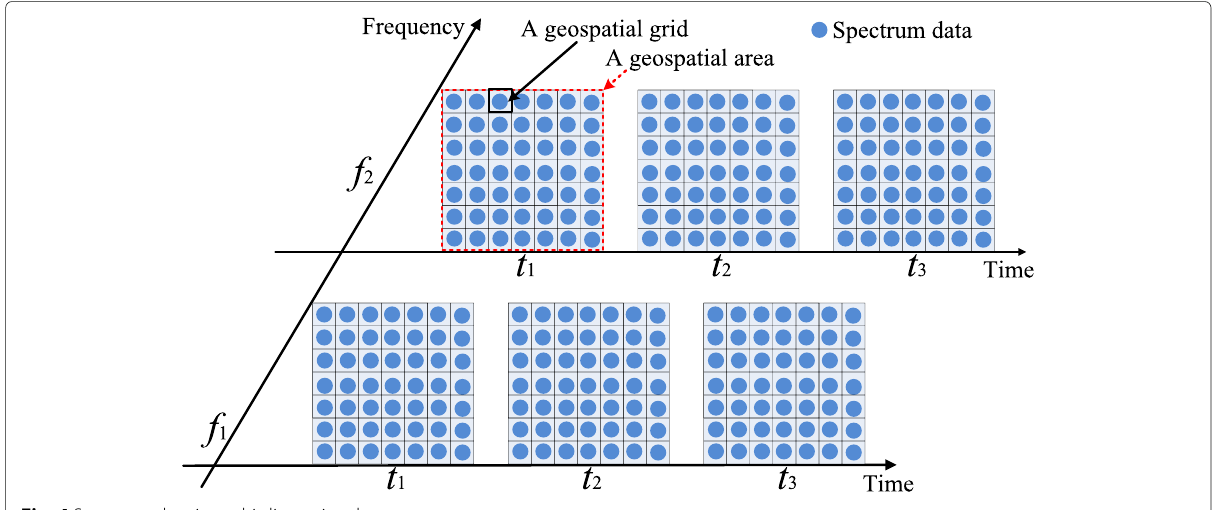
Fig. 4 Spectrum data in multi-dimensional